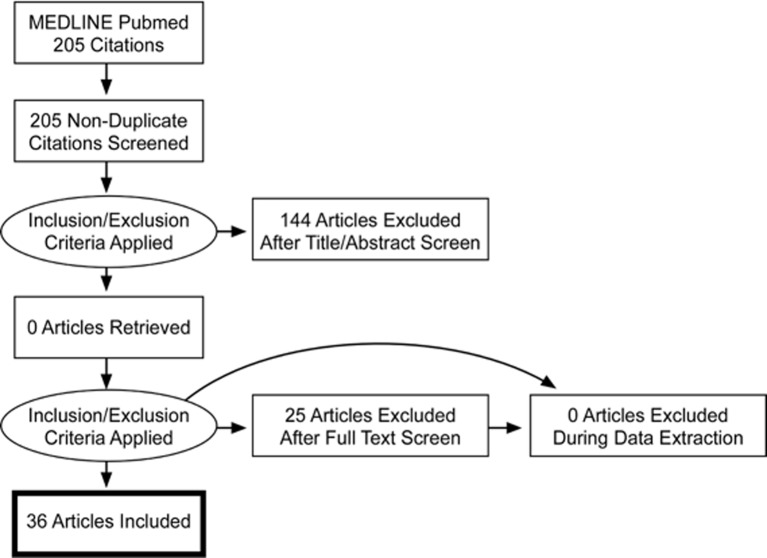
PRISMA Flowchart diagram.